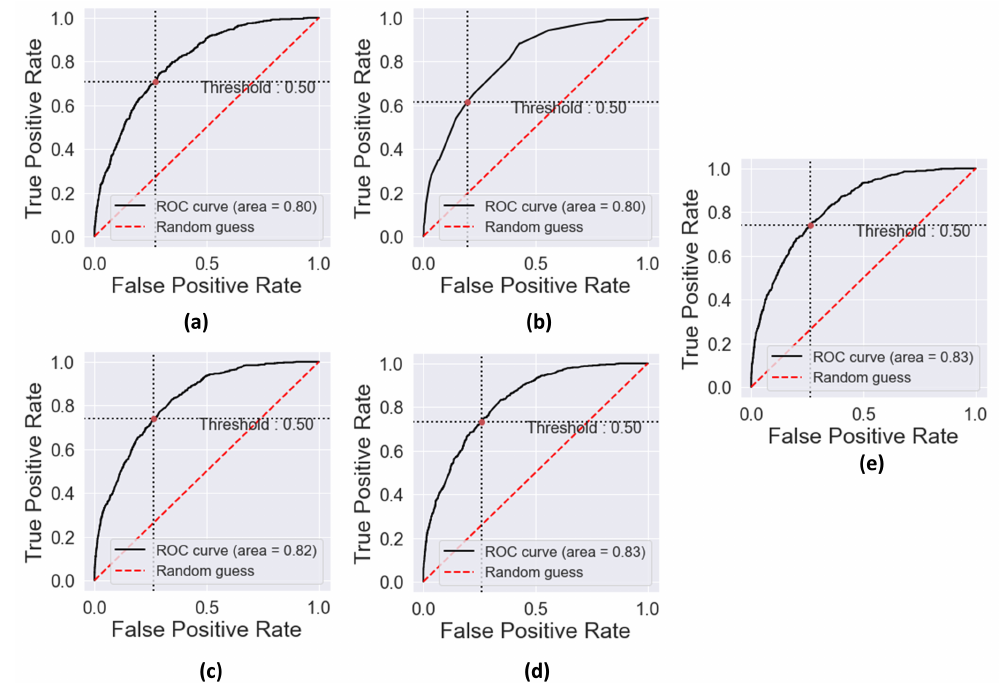
Figure 9. Area under the ROC curve. ( a ) Logistic Regression model. ( b ) Decision Tree-CART model. ( c ) Random Forest model. ( d ) Gradient Boosting model. ( e ) XGBoost